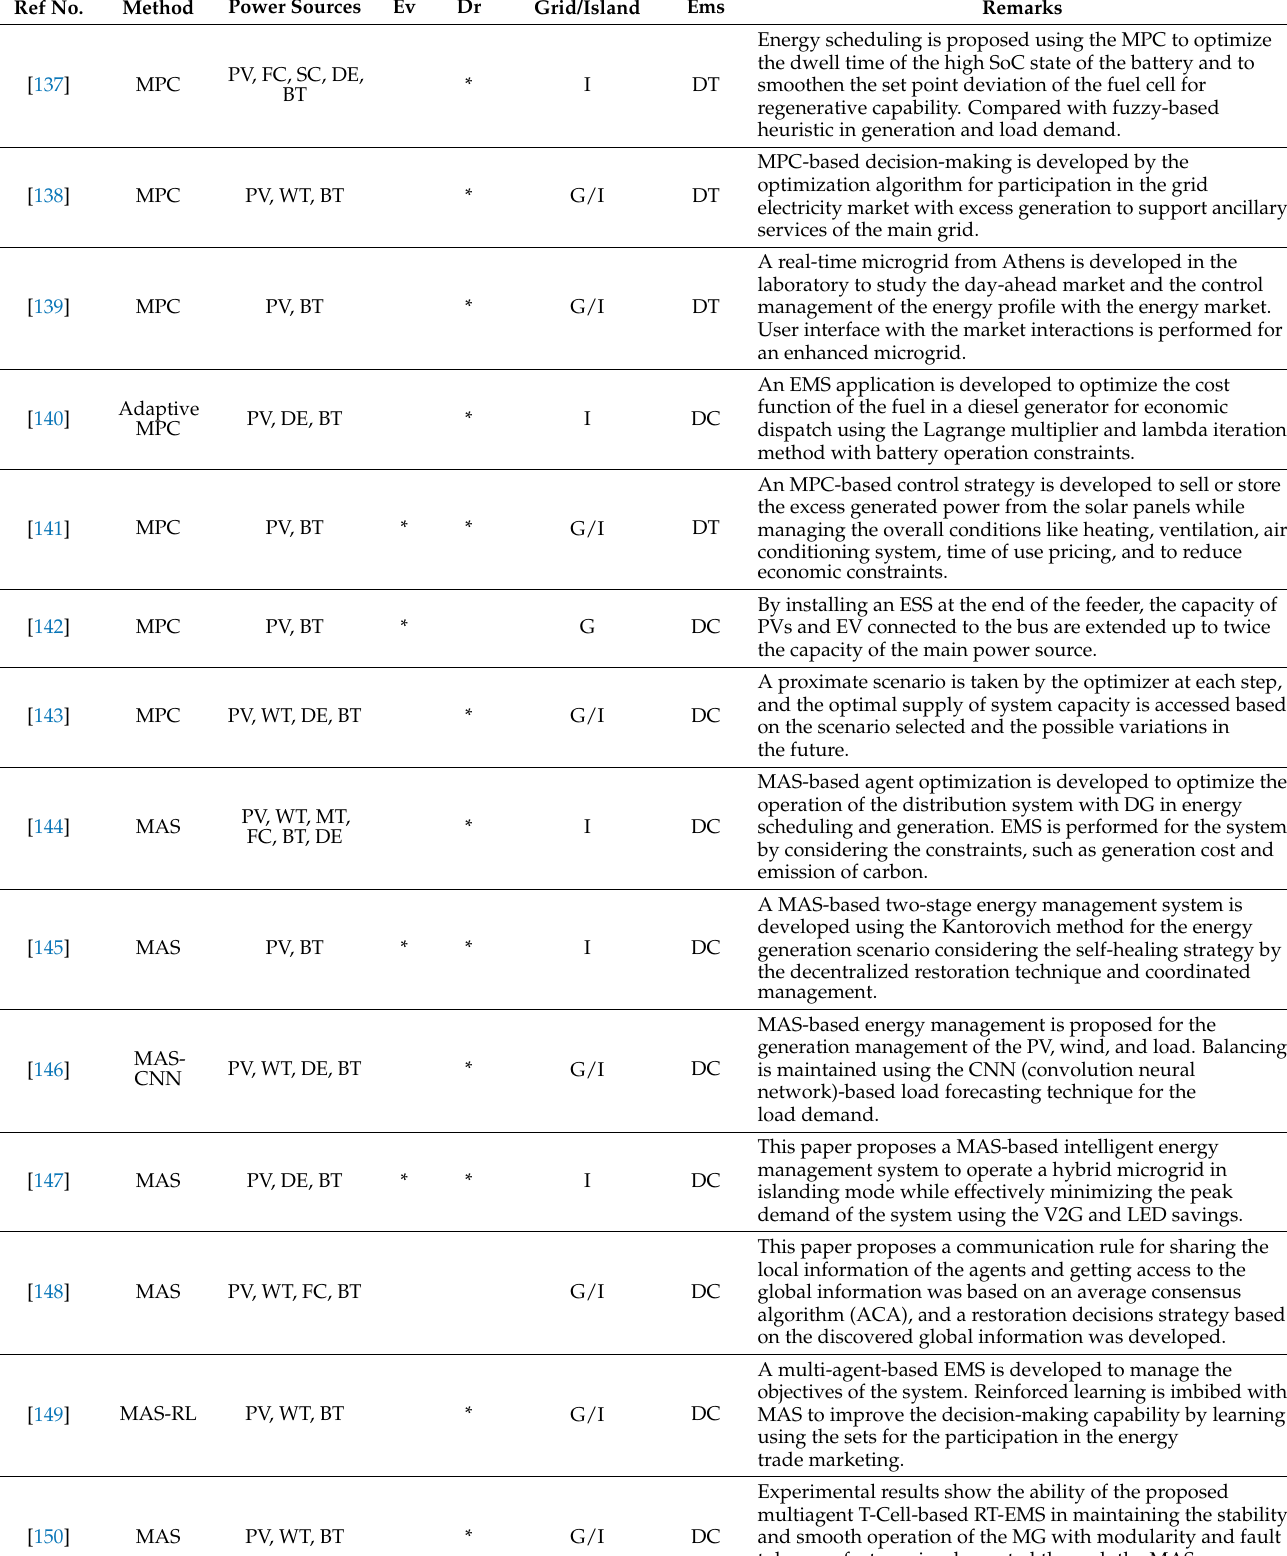
Table 8. A review on MPC and MAS based on